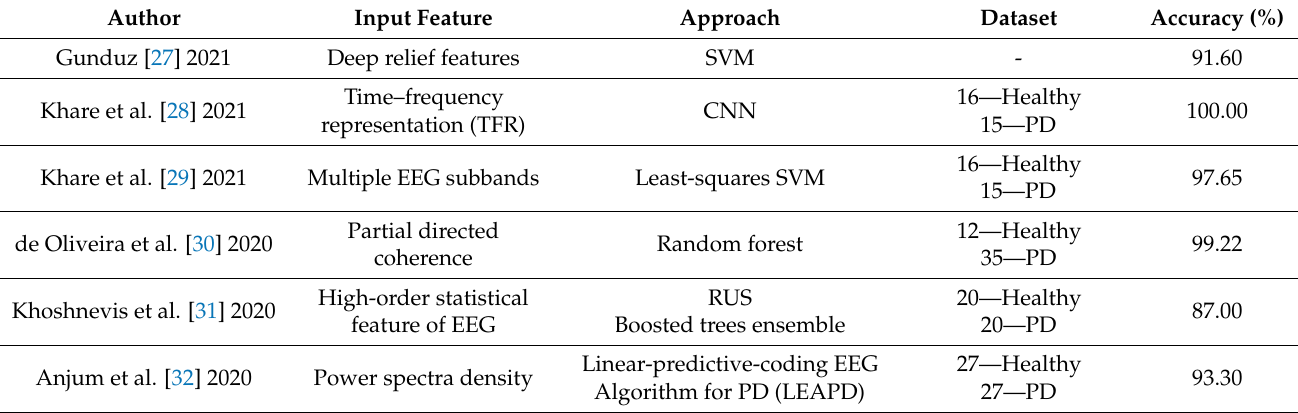
Table 1. List of automated Parkinson’s disease (PD)detection studies from 2016 to